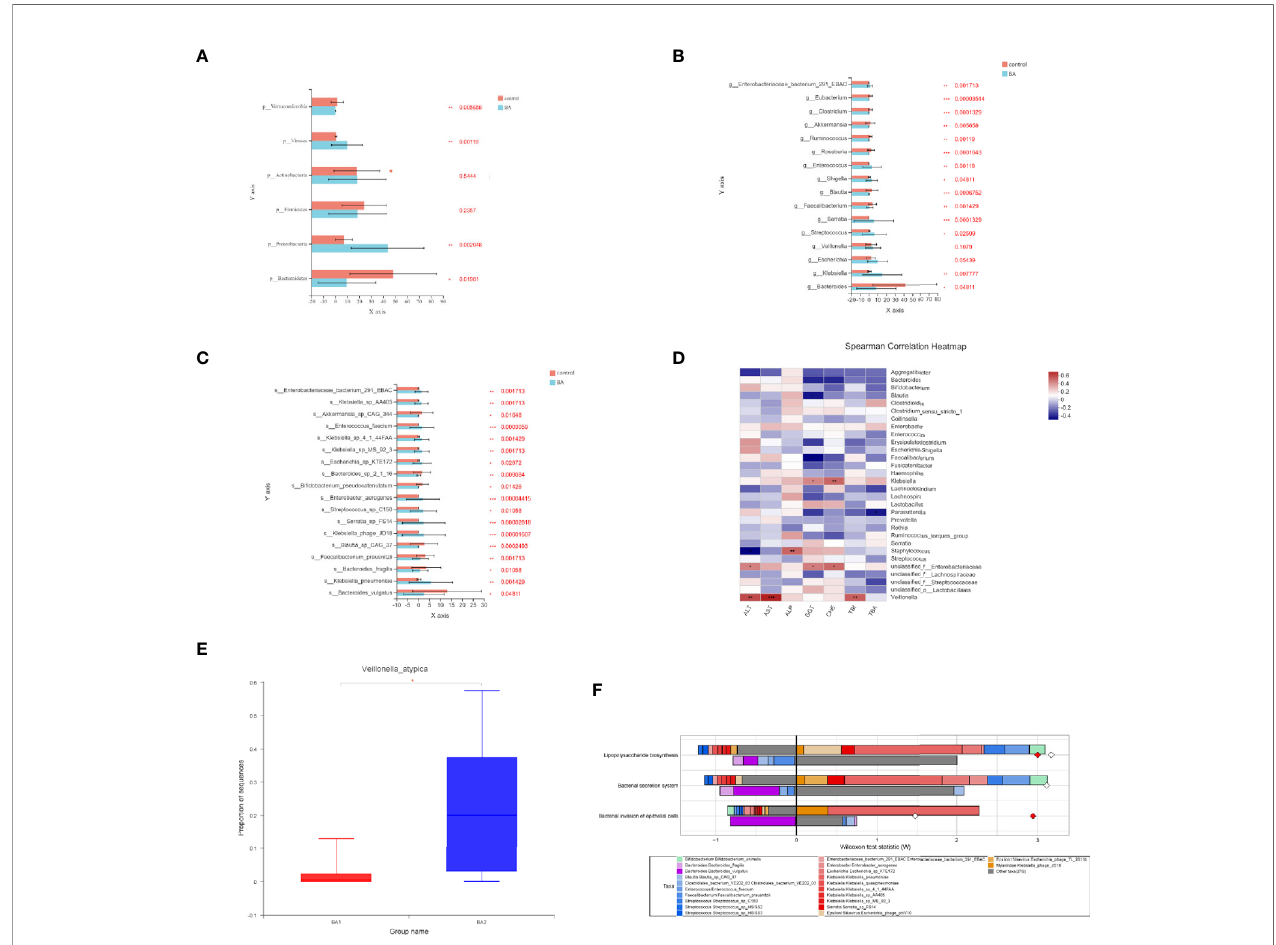
FIGURE 2 | (A – C) Microbiota enriched in the different groups (patients with later-stage biliary atresia and controls) at the phylum, genus, and species levels (* p < 0.05, ** p < 0.01, *** p < 0.001). Different colors represent different groups. Orange denotes the control group and blue biliary atresia (BA). (D) Correlations between liver function indicators and gut microbiome in different stages of biliary atresia (Spearman correlation test). The x-axis represents the environmental factors, and the y axis the species. The depth of the color indicates the correlation between species and environmental factors. Blue denotes negative correlation and red positive correlation (* p < 0.05, ** p < 0.01, *** p < 0.001). (E) Changes in the abundance of V. atypica in early and later biliary atresia (BA1, early-stage biliary atresia; BA2, later stage biliary atresia). (F) FishTaco analysis of species contribution to metabolic pathways. The x-axis represents the Wilcoxon test statistic scores, and the y-axis the related functions. The driving factors for each differential function transformation were divided into four parts, represented by a histogram in two directions. Gut microbiota in the biliary atresia group drove the increase in the corresponding functional abundance (top right). Gut microbiota in the biliary atresia group inhibited the proliferation in the related practical quantity (top left). Gut microbiota in the control group drove the increase in the related functional mass (bottom right). Gut microbiota in the control group inhibited proliferation in the corresponding available abundance (bottom left). Different color bars represent the related species. The longer the bar, the greater the driving or inhibitory effect of the species on the corresponding